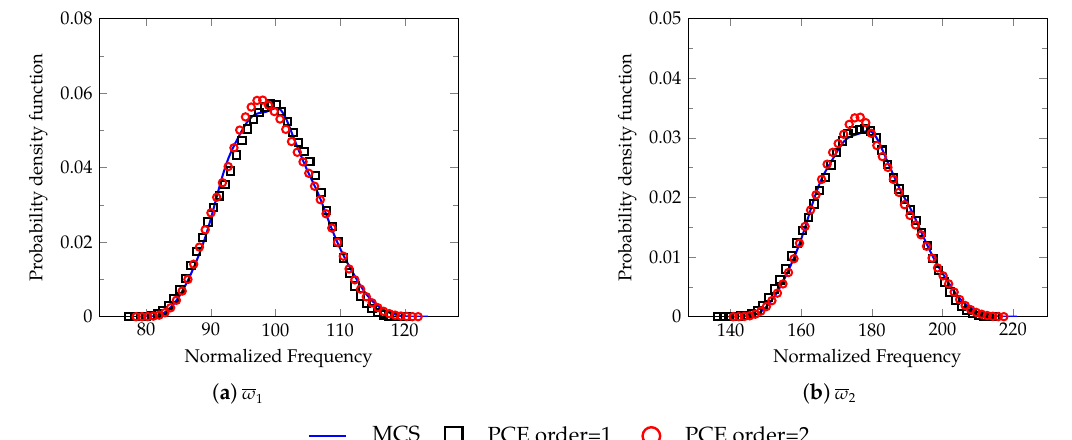
Figure 8. Case D: Variation of the probability density function as a function of normalized frequency, for the first two normalised frequencies; considering gradient index, n = 5 and the Young’s modulus and density of both metal and ceramic as random.